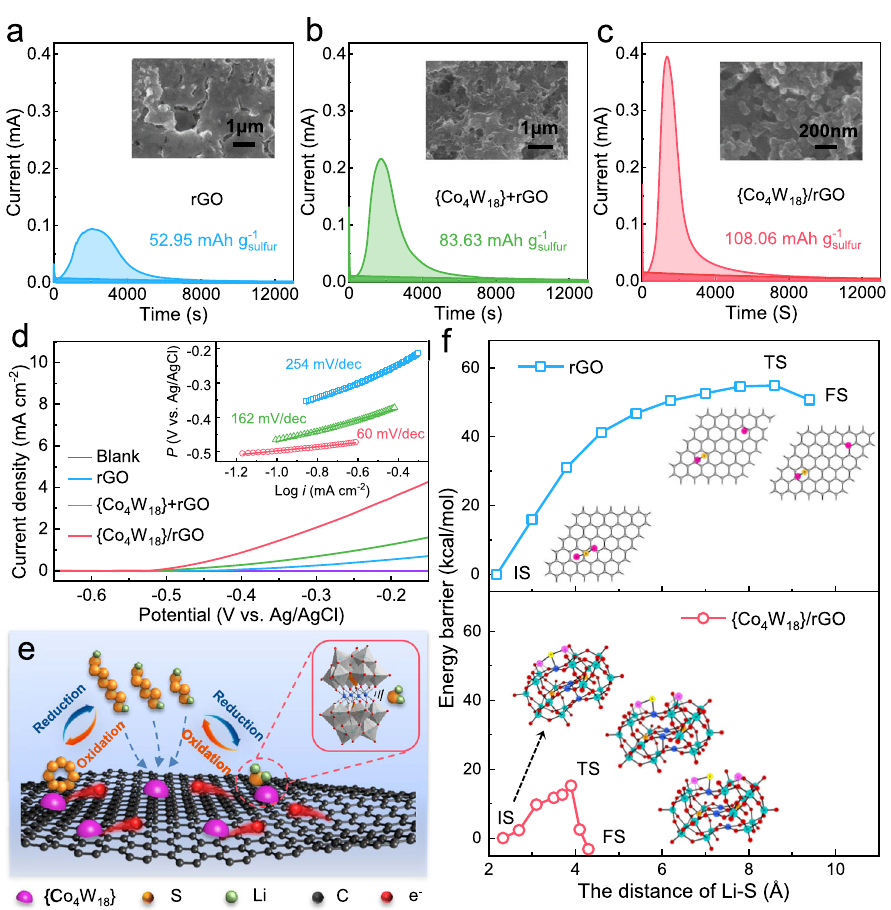
Fig. 3 Bifunctional catalytic behaviors of Li 2 S deposition and oxidation. a – c Potentiostatic nucleation pro fi les of Li 2 S 8 solution on the rGO, {Co 4 W 18 } + rGO, and {Co 4 W 18 }/rGO electrodes. The dark and light areas correspond to the reduction of Li 2 S 8 /Li 2 S 6 and the Li 2 S deposition, respectively. The insets are the SEM images of electrodes after Li 2 S deposition. d LSV curves and Tafel plots of Li 2 S oxidation on the rGO, {Co 4 W 18 } + rGO, and {Co 4 W 18 }/rGO electrodes. e Schematic illustration of bifunctional catalytic effect for Li 2 S deposition and oxidation on the surface of {Co 4 W 18 }/rGO composites. f Energy pro fi les for Li 2 S → LiS + Li on rGO (blue line) and {Co 4 W 18 } (red line), respectively. The inserted pictures are the optimized structures of the initial state (IS), transition state (TS), and fi nal state